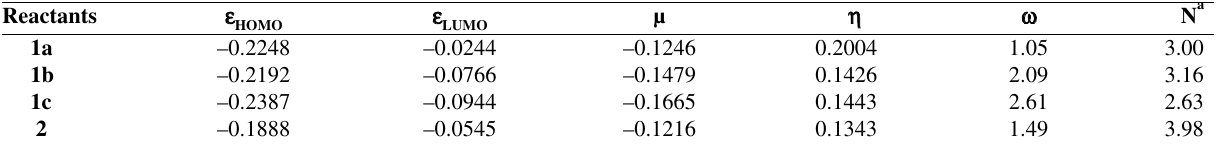
Table 2. HOMO and LUMO energies in a.u., electronic chemical potential (μ in a.u.), chemical hardness ( η in a.u.), global electrophilicity ( ω , in eV) and global nucleophilicity (N, in eV) for reactants 1a – c and 2 . Reactants